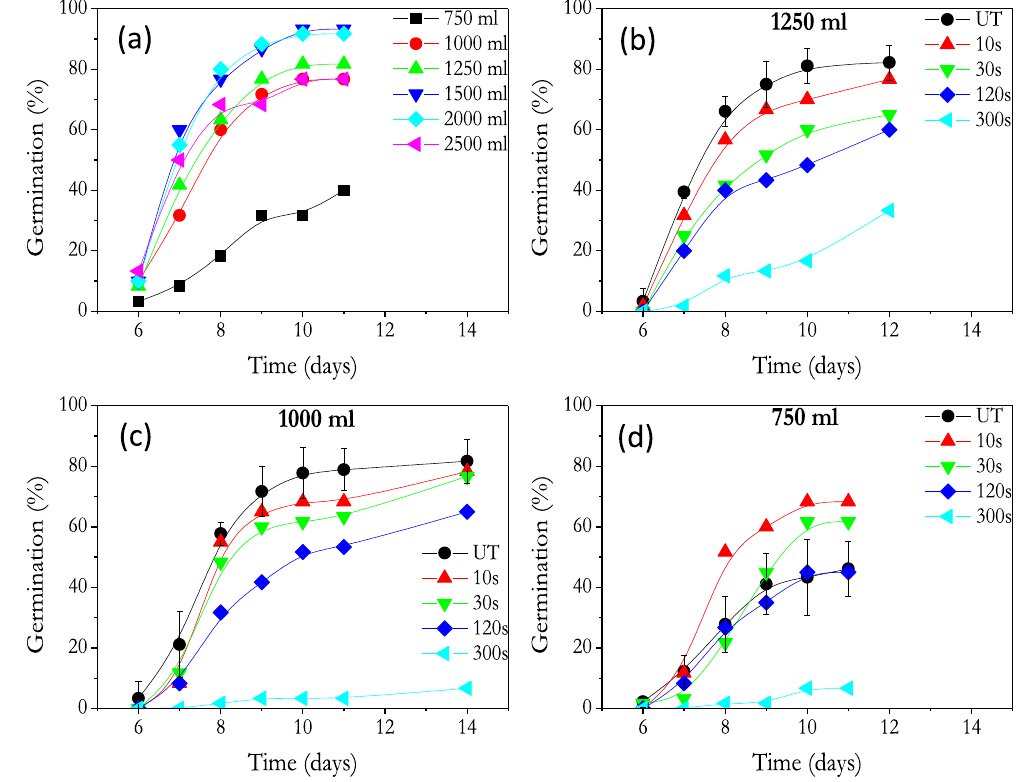
Figure 1. Germination rate of untreated (UT) and atmospheric plasma treated nasturtium seeds for the indicated periods of time. ( a ) Untreated nasturtium seeds as a function of irrigation conditions. ( b – d ) Germination for untreated and plasma treated nasturtium seeds for water irrigations with 1250 ml, 1000 ml and 750 ml,